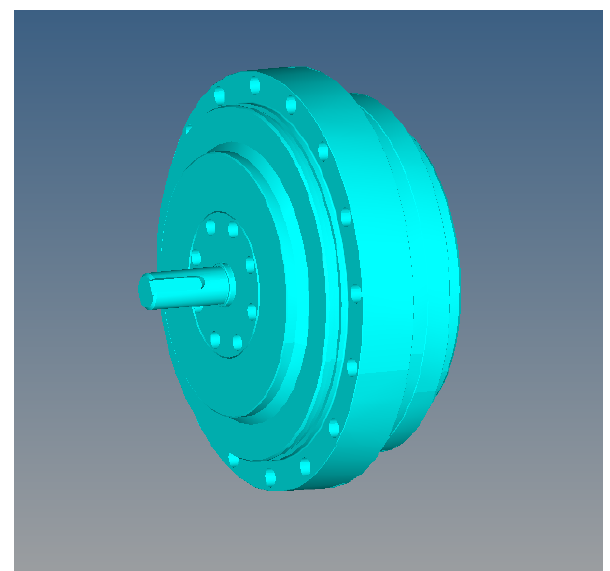
Figure 6. Geometric dynamic analysis